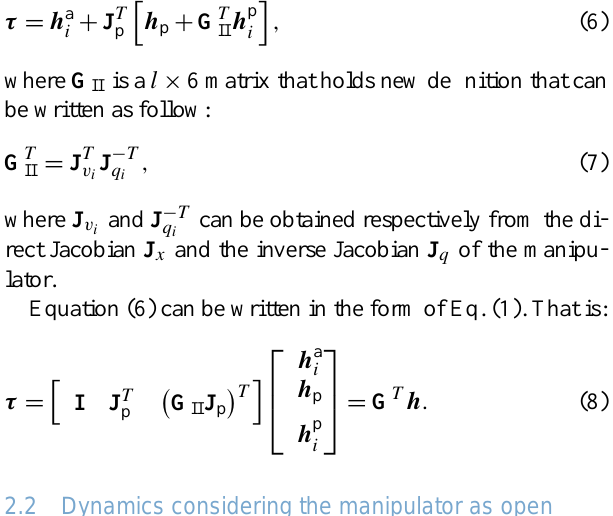
Figure 2. Several open chains obtained after cutting open the par- allel